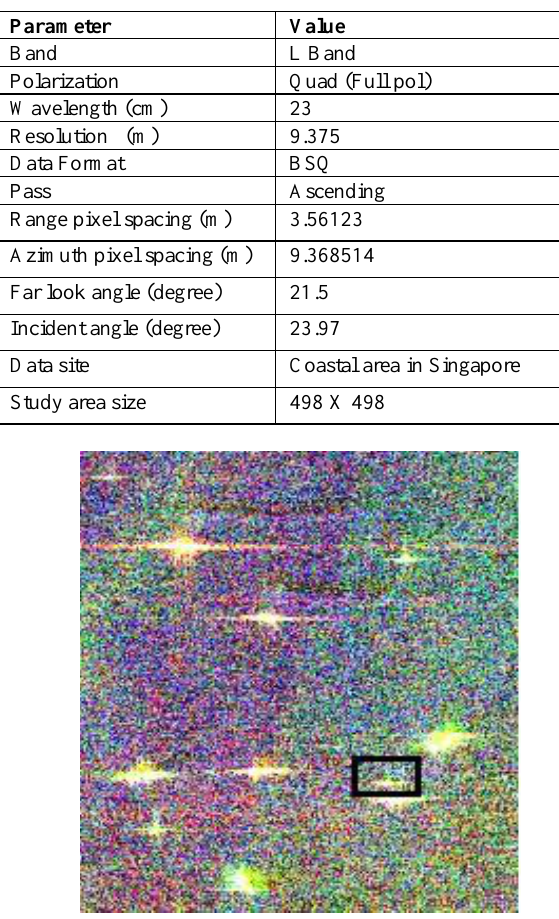
Table 1 ALOS-1 Input data details